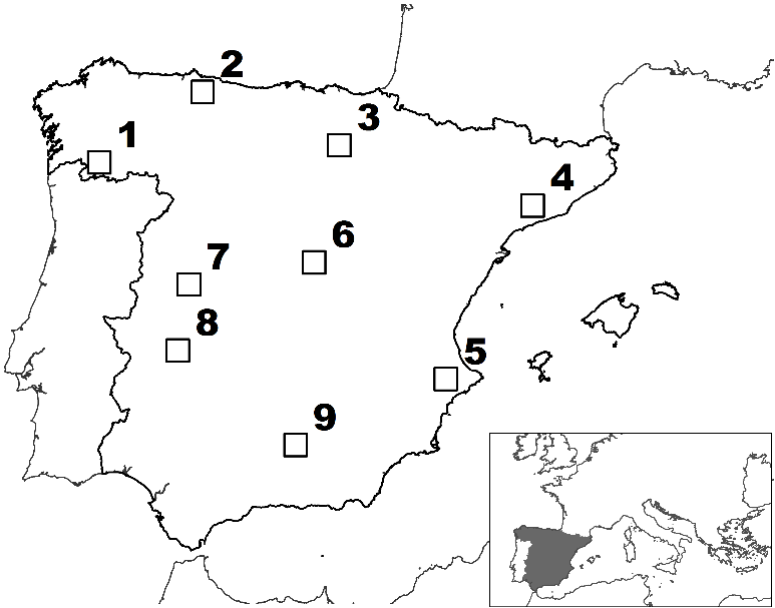
Figure 1. Location of the nine study areas in the Spanish peninsula. 1. Ourense; 2. Asturias; 3. La Rioja; 4. Tarragona; 5. Alicante; 6. Guadalajara; 7. Caceres; 8. Badajoz; 9. Jaen. Table 1. A subset of independent variables for general characterization of each study area.